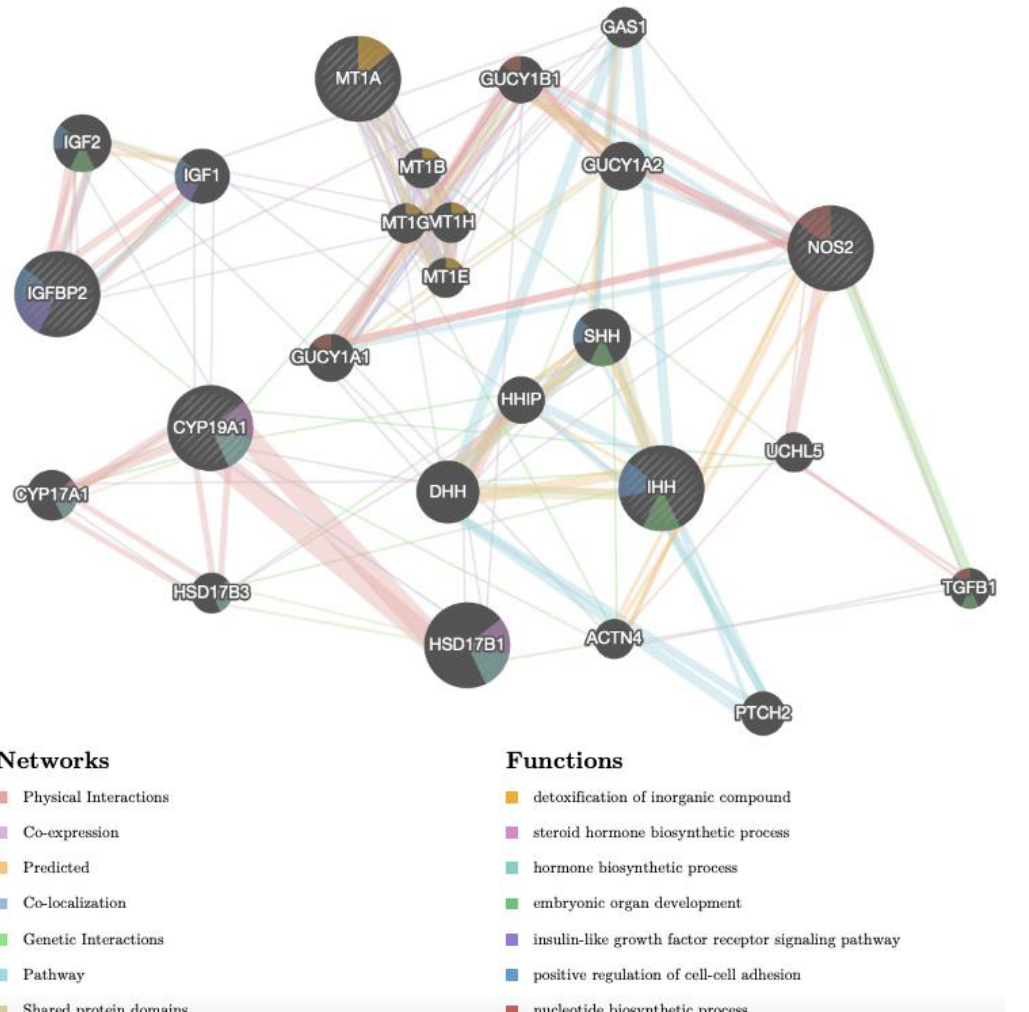
Figure 4. Gene network of DEGs (NOS2, IGFBP2, CYP19A1, IHH, MT1A), selected after tran- scriptomic analysis upon Cd treatment in CCs of adult sheep and analysed by GeneMANIA (http://www.genemania.org, accessed on 14 December 2022). The differently coloured the lines in- dicate the bioinformatics methods applied: co-expression, website prediction, pathway, physical in- teractions, and co-localization. The differently coloured network nodes indicate the biological func- tions of the set of enrichment genes.